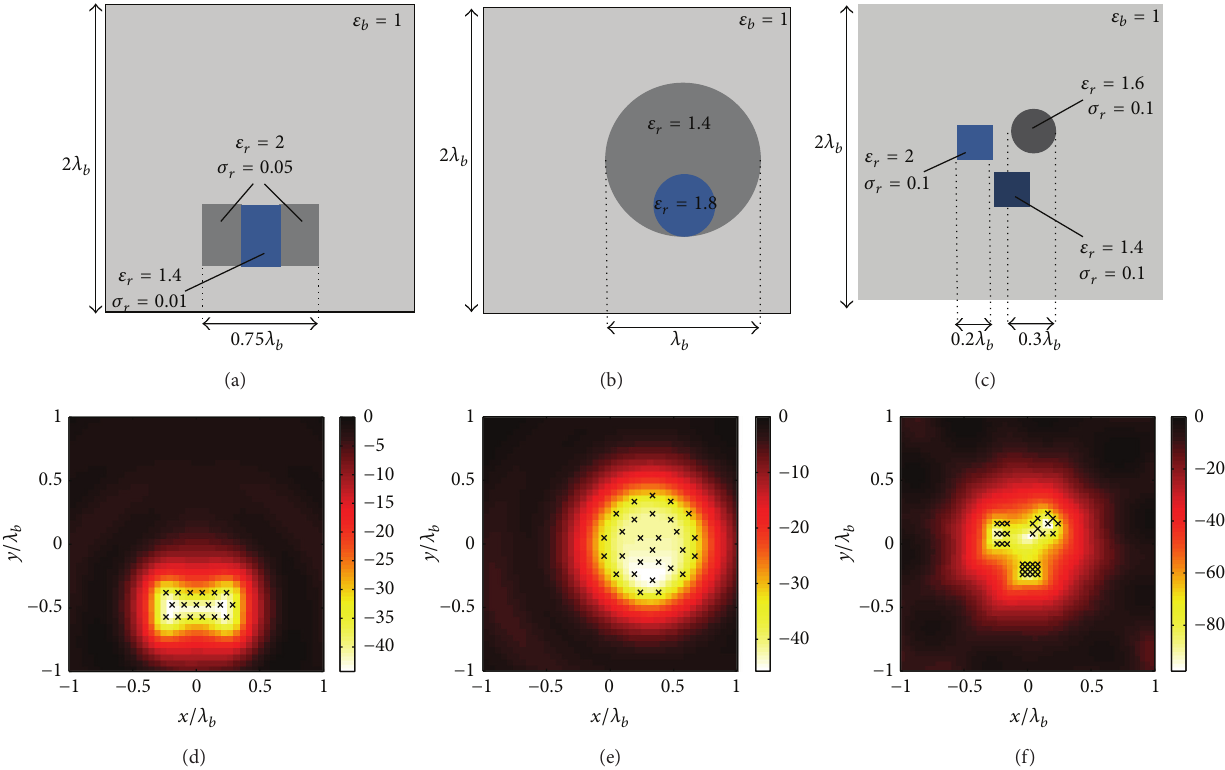
Figure 4: Reference profile for (a) example 1, (b) example 2, and (c) example 3. Support estimation via LSM indicator and the selected pivot points for (d) example 1 ( 𝑁 𝑝 = 18), (e) example 2 ( 𝑁 𝑝 = 28), and (f) example 3 ( 𝑁 𝑝 =